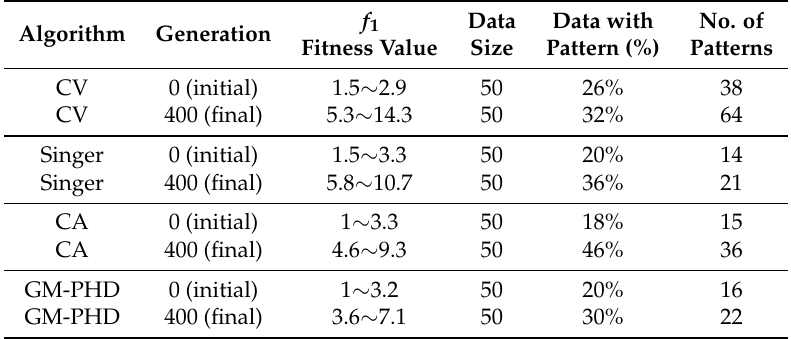
Figure 11. Three motion patterns in scenario (with noise) “GEN 174, No. 1, f 1 = 8.4”. Table 1. Statistics of snapshot cluster pattern (with noise) for the four tracking algorithms.